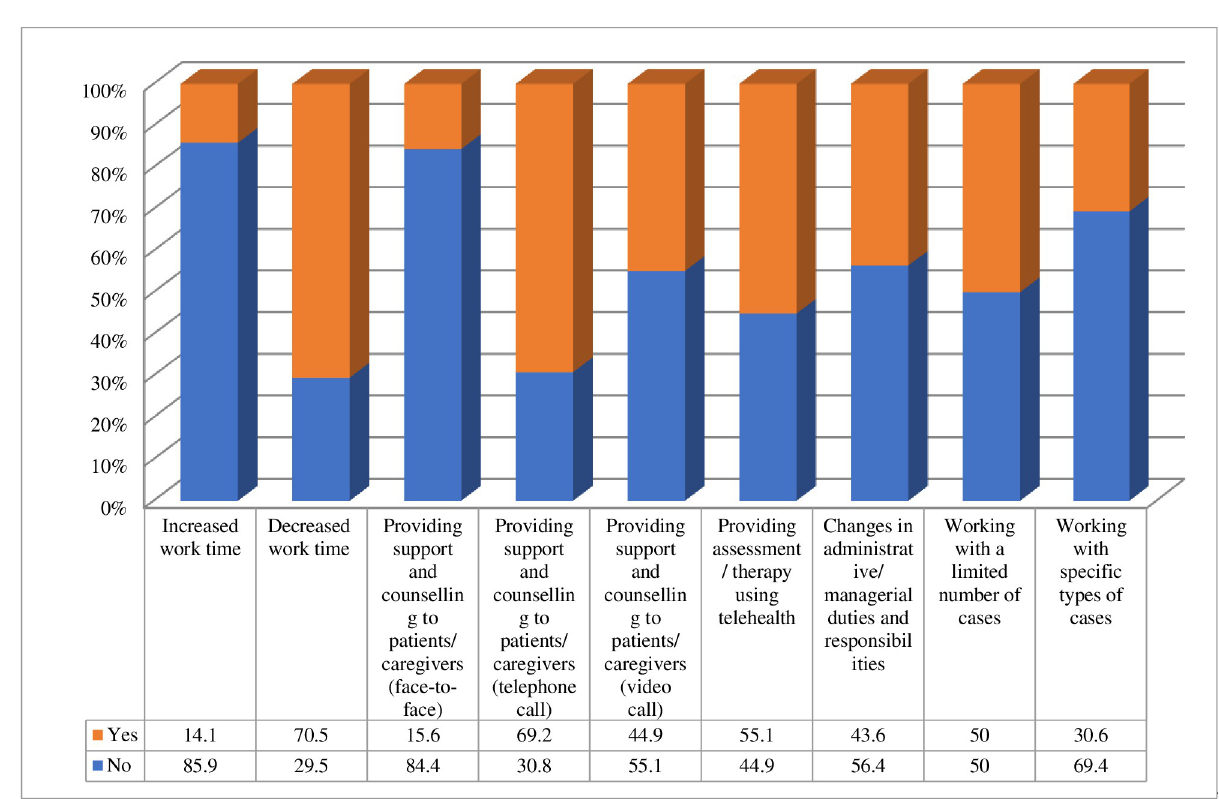
Fig 1. Changes experienced by SLPs during the COVID-19 pandemic (n = 86).